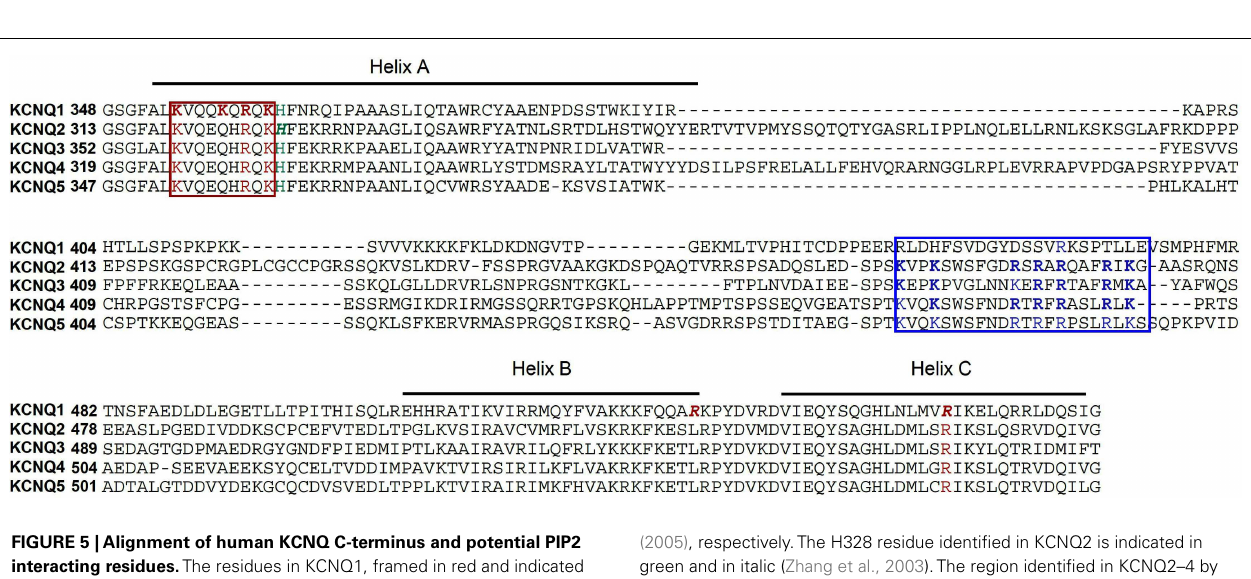
FIGURE 4 | Model of regulation of KCNQ channels function by the Gq signaling pathway. (A) Activation of the PLC by ACh and angiotensin II induces the hydrolysis of PIP 2 to DAG and IP3. (B) Activation of bradykinin and purinergic receptors leads to depletion of PIP 2 by PLC but also its